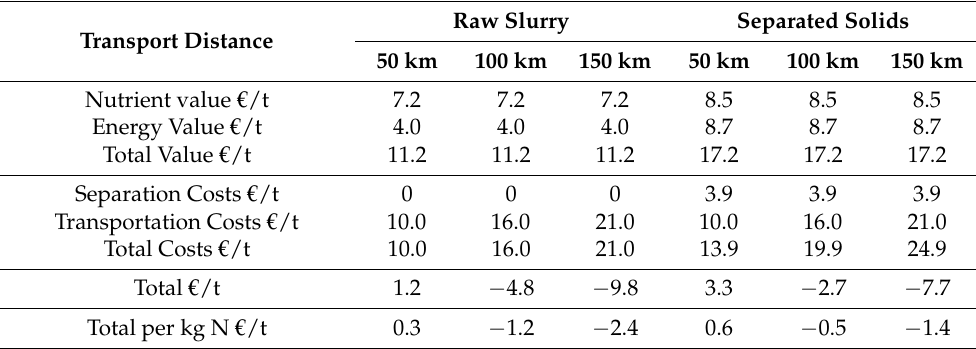
Table 4. Results for transportation costs of raw and separated manure solids over a range of distances (reproduced by permission from Kroger and Theuvsen, 2013